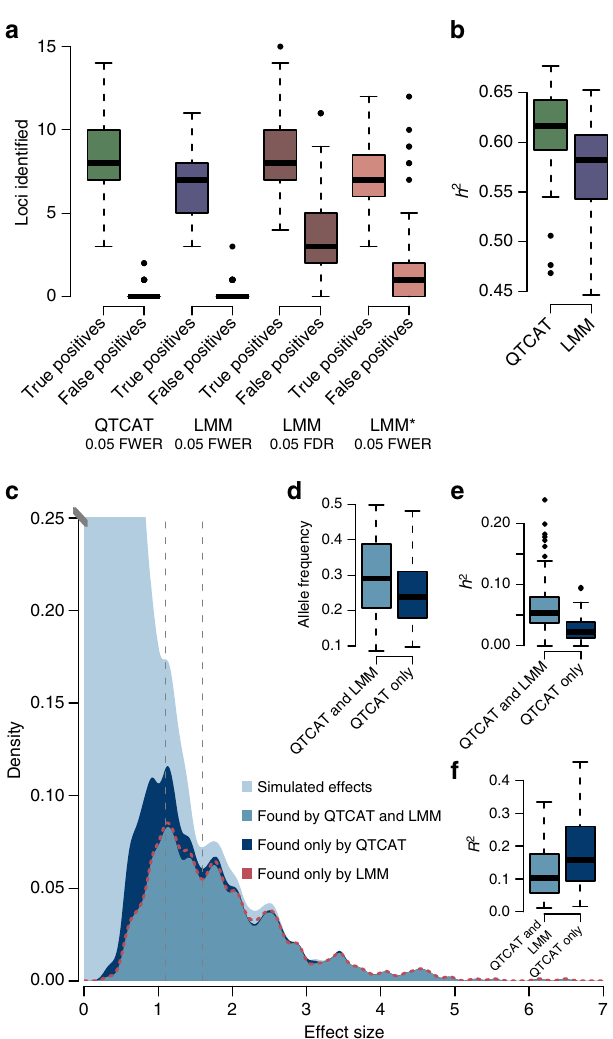
Figure 3 | Analysis of the results of GWA simulations using structured populations (Phenotype 1). ( a ) Number of true and false positive loci identified by QTCAT and LMM (with multiple testing correction based on FWER and false discovery rate (FDR) shown separately). ( b ) The explained variance of the loci identified by QTCAT and LMM within the 100 simulations. ( c ) The distribution of all simulated effects (light blue) and the distribution of effects of loci identified by QTCAT (dark blue) and the intersection of found loci of QTCAT and LMM (blue). The dashed red line shows the findings of the LMM. Although QTCATand LMM find almost all of the large effect loci, QTCAT is more efficient in finding small effect loci. ( d ) Difference between the allele frequencies of loci found by both methods and by QTCAT alone ( P -value ¼ 0.02765, Wilcoxon test). ( e ) Differences between explained variances of loci found by both methods and by QTCAT alone ( P -value ¼ 8.697e (cid:3) 10, Wilcoxon test). ( f ) Compared with the loci identified by both methods, loci found by QTCAT alone were significantly more involved into population structure ( P -value ¼ 0.005335, Wilcoxon test one-sided). Boxplots show median (bold line), the first to third quartile (box) and whiskers showing span of remaining data (max. 1.5 times of the box size). Population structure involvement was estimated by the explained variance of the first five principal coordinates of the GRM regressed to the individual markers. It is noteworthy that for d , e and f , only loci with similar effect sizes were considered (between 1.1 and 1.6, see grey dashed lines in c ). and 20 causal loci with effects that were randomly drawn from a Gamma distribution (Supplementary Methods and Supplemen- tary Figs 301–400). NATURE COMMUNICATIONS|7:13299|DOI: